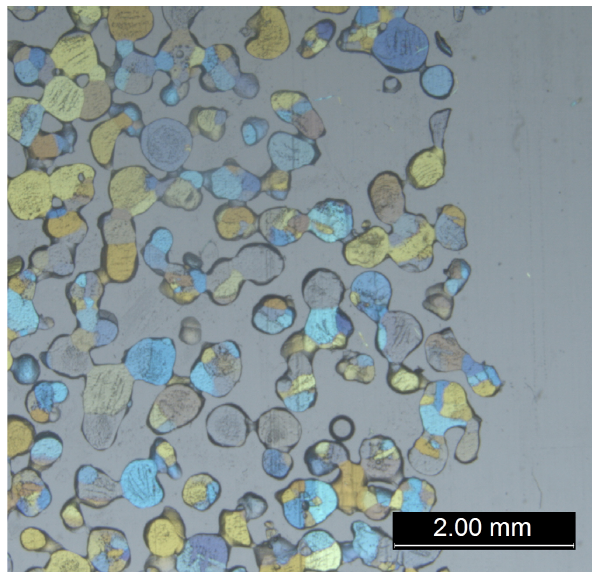
Fig. 5. Thin slice of a polycrystalline ice sample as seen under a polarization microscope. Coloured areas visualize individual ice crystals. The slice also shows the porosity of the snow